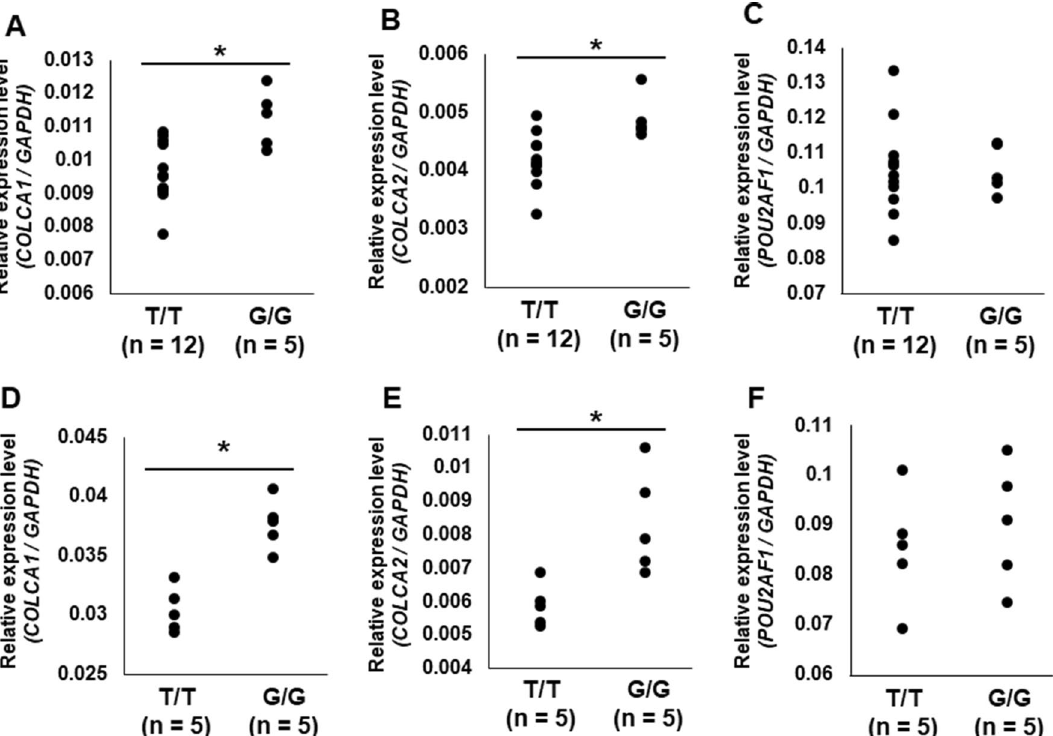
Figure 3. Effects of rs1944919 on gene expression in knock-in clones generated using the CRISPR/Cas9 system. Expression levels of COLCA1 ( A ), COLCA2 ( B ), and POU2AF1 ( C ) in rs1944919-G/G and rs1944919-T/T knock-in clones of the Raji cell line. Expression levels of COLCA1 ( D ), COLCA2 ( E ), and POU2AF1 ( F ) in rs1944919-G/G and rs1944919-T/T knock-in clones of the Jurkat cell line. * P < 0.01 (Mann–Whitney U